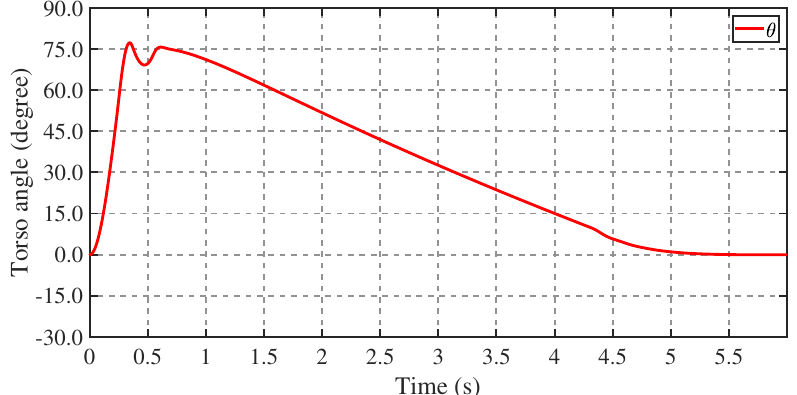
Figure 17. Trajectory of the torso angle when the robot is sliding.